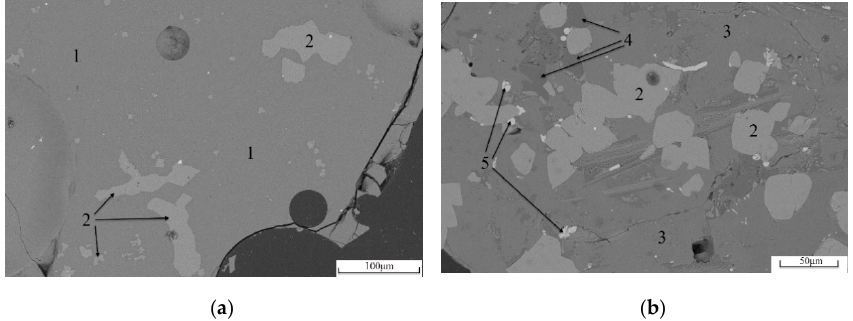
Figure 2. SEM images of two kinds of high-titanium slag. ( a ) TS; ( b ) TM.